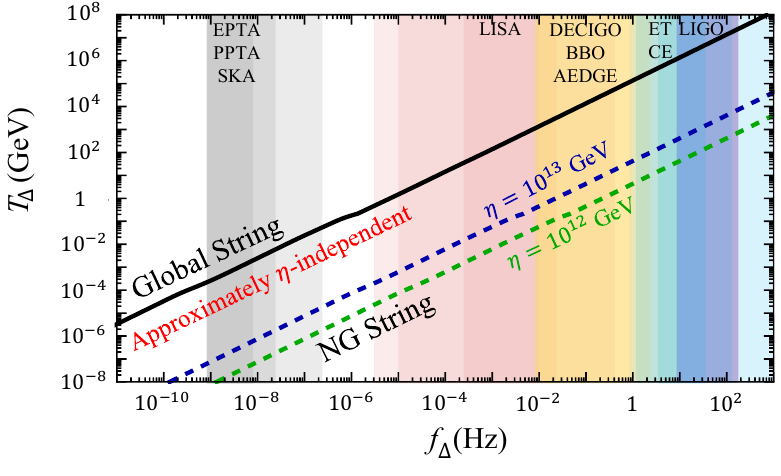
Figure 6 . Frequency f ∆ where the GW spectrum from cosmic strings would be altered due to a transition to a non-standard cosmology at T (eq. (4.1)): the comparison between the results ∆ for global strings (the upper-left black line) and NG strings [21, 22] (the lower-right dashed lines). The relevant experimental sensitivities are also shown in different colors, where the darkest bands indicate peak sensitivities. This illustrated the f relation given in the main text. ∆ − T ∆